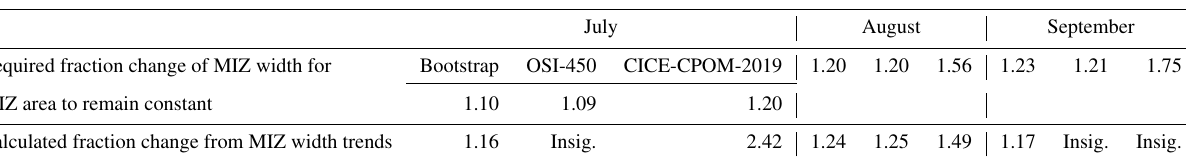
Required fraction change of MIZ width